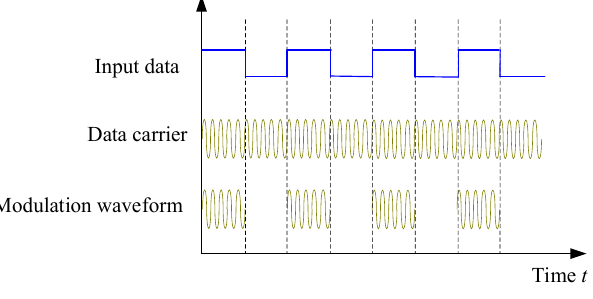
Figure 2. The principle of data modulation.